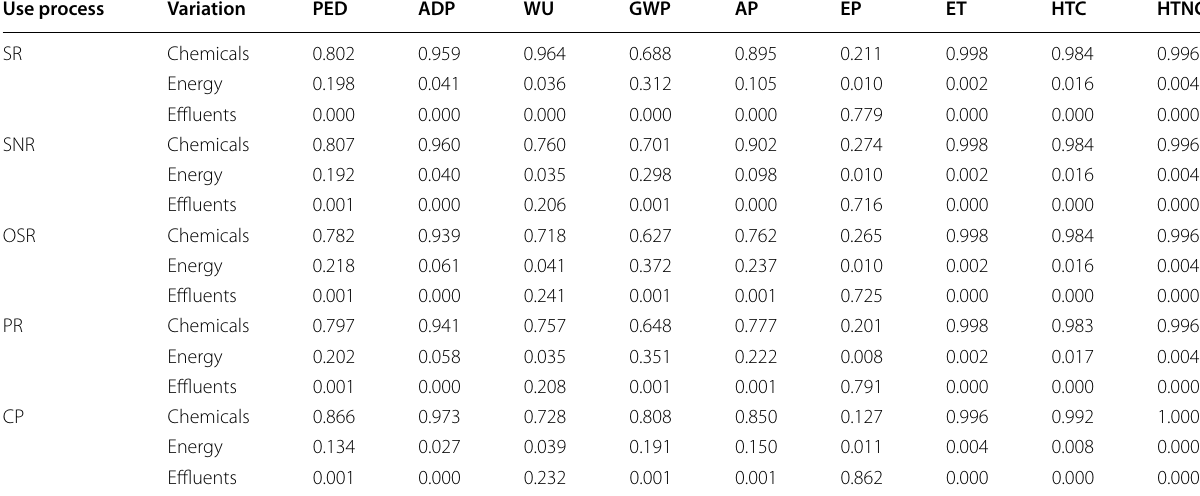
Table 2 Sensitivities of chemicals, energy, and effluents to impact categories for various fatliquor use processes Use